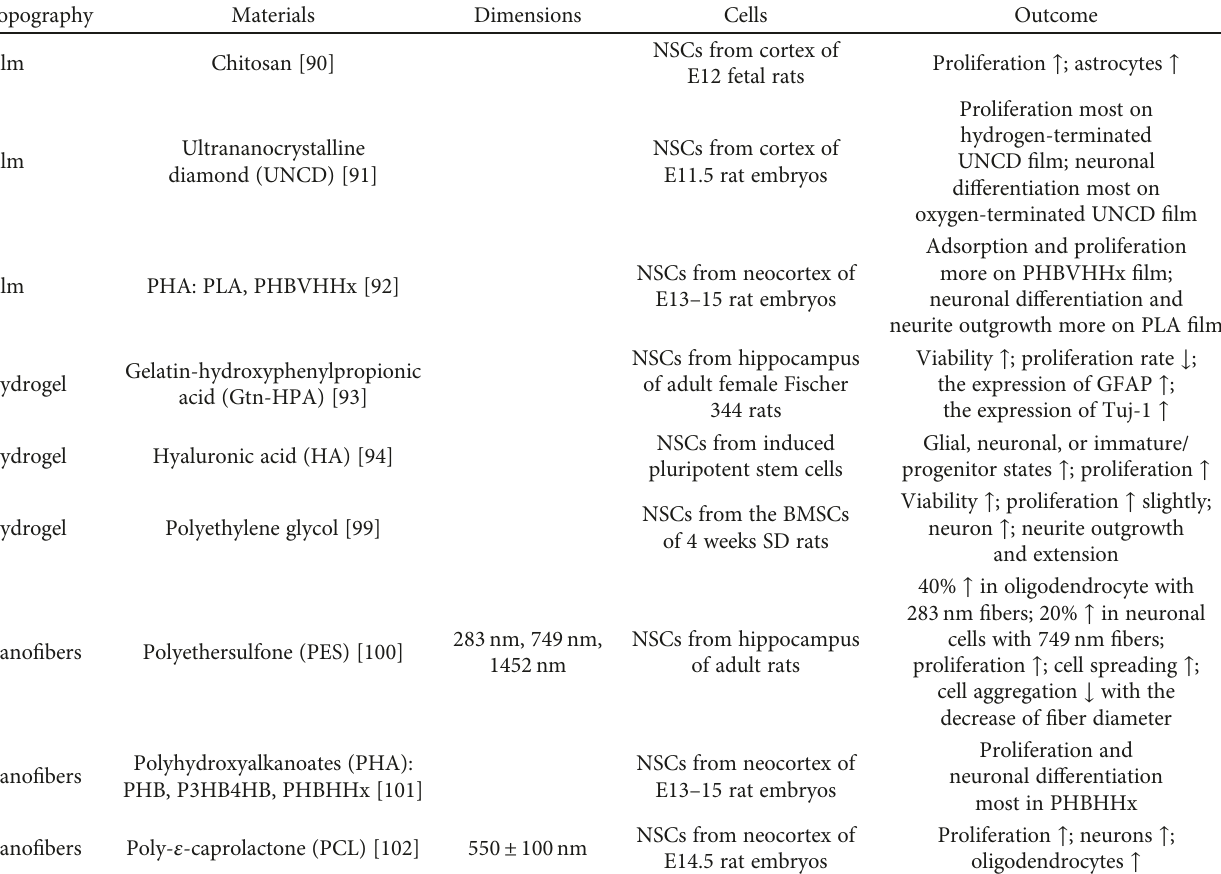
Table 3: E ff ects of biomaterials on the proliferation and di ff erentiation of